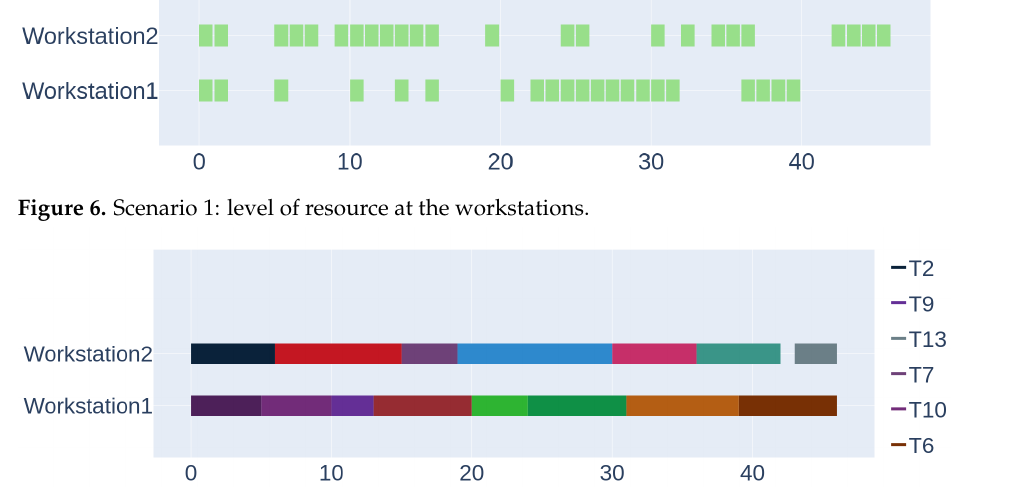
Figure 7. Scenario 1: Tasks’ assignment—trained agents.